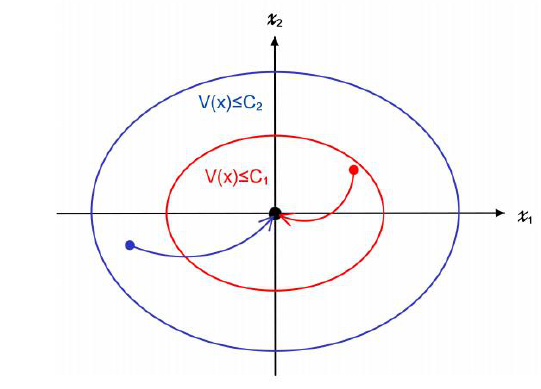
Fig. 1. Illustration on the level set of Lyapunov